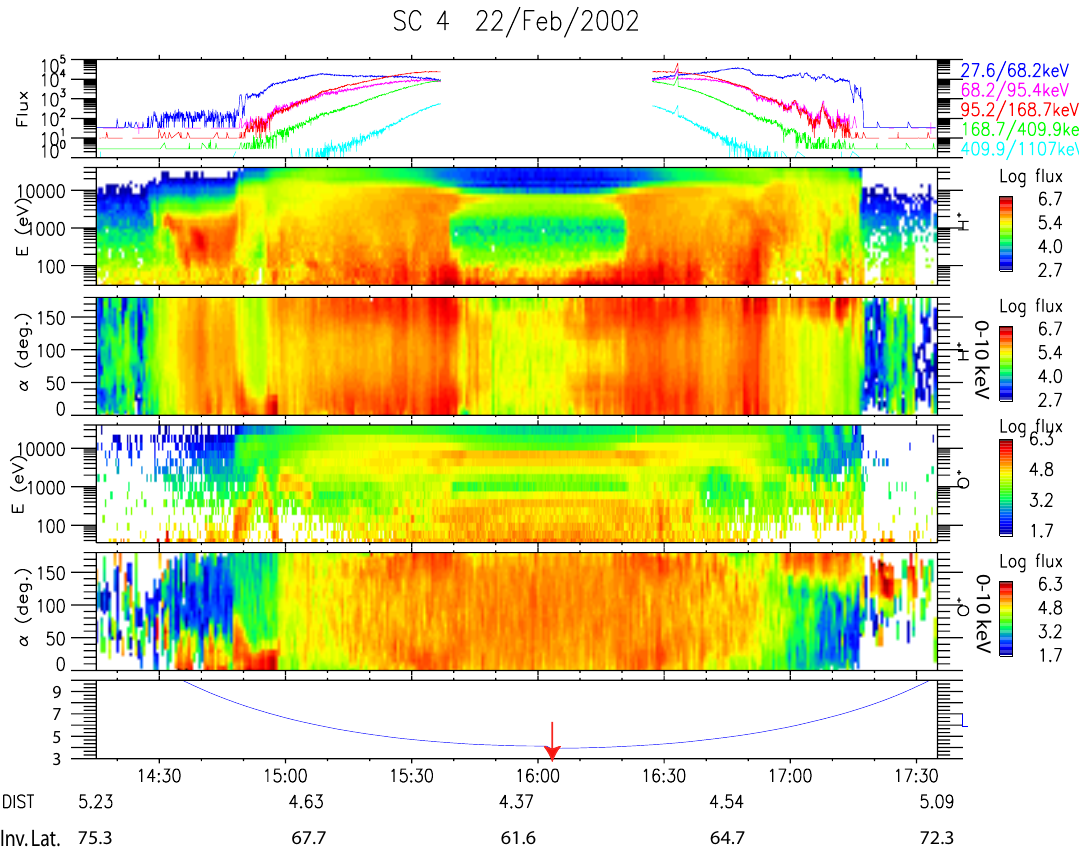
Fig. 1. SC4 particles data for the 22 February 2002 event. From top to bottom: RAPID proton flux in flux units, CIS/CODIF proton flux in flux units, the proton pitch angle distribution in flux units for the 0–10keV energy range, the O + flux in flux unit, the O + pitch angle distribution in flux unit for the 0 to 10keV energy range and the L-shell values crossed by the spacecraft. Radial distance in R E and invariant latitudes are indicated at the bottom of the plot. Red arrow indicated the equator